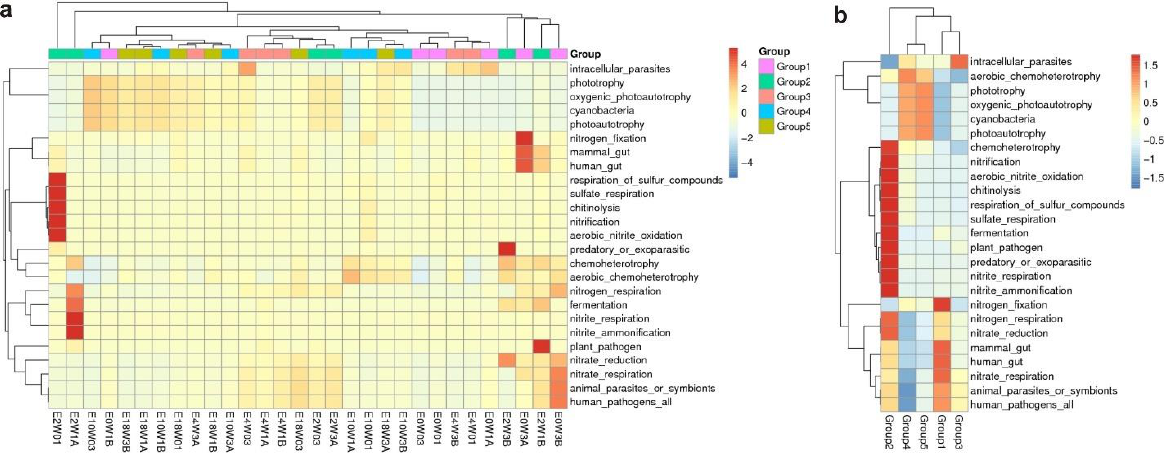
Figure 7. Clustering of functional prediction based on samples ( a ) and sample groups ( b ) for microbiomes of S. palustre based on the FAPROTAX database .